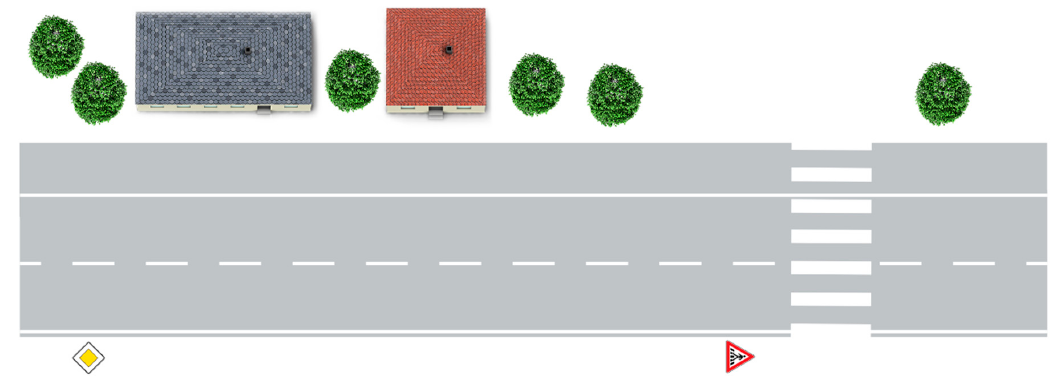
Figure 2. Static characteristics of an urban road scenery. The static influencing factors in this example include a two-lane road, a bike lane, and a zebra crossing. The traffic signs provide further information about the prevailing traffic rules. Additionally, the scenery includes houses and trees.